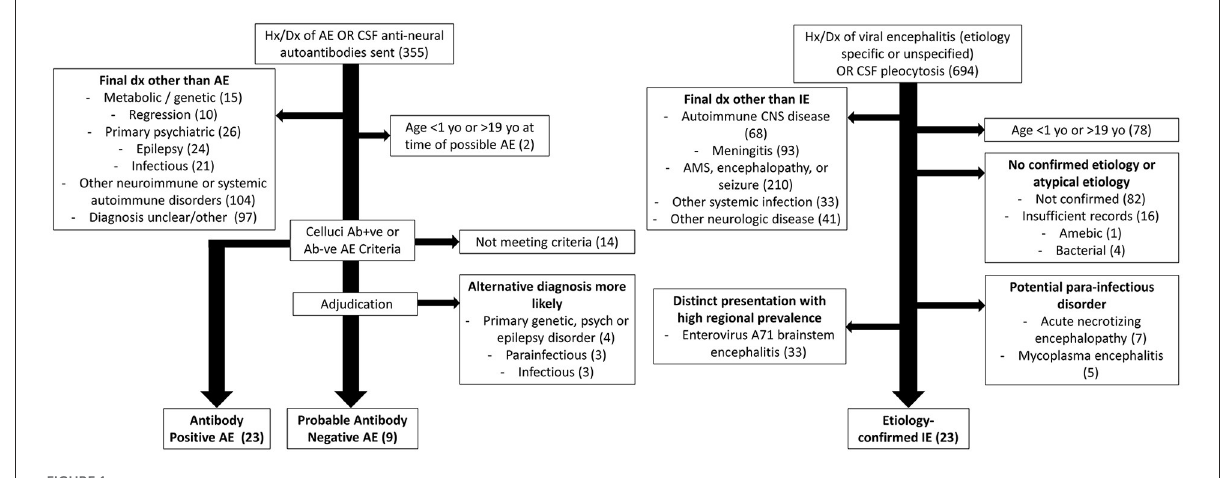
FIGURE1 Inclusion and exclusion of patients with AE or